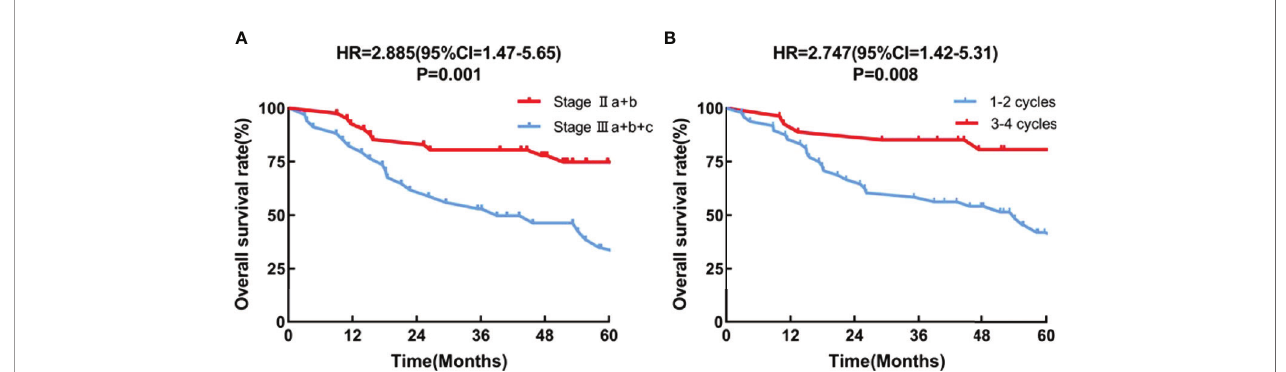
FIGURE 3 | Overall survival curves of subgroups (A) pathologic stage, (B) chemotherapy cycles.